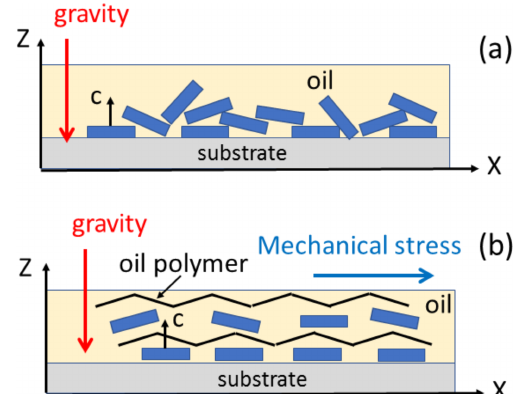
Figure 11. Models for the sedimentation of pigment microcrystals in oil leading to (a) poorly oriented crystals upon dabbing or droplet deposition and (b) an enhanced orientation when the oil polymers are stretched by an in-plane mechanical stress in the case of brush painting or deposition with an